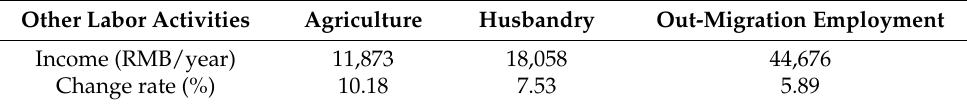
Table 3. Income from other labor activities and their rates of